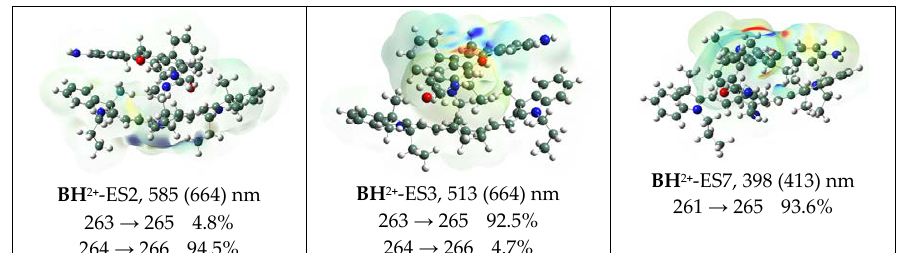
Figure 9. Current density difference illustrations as iso-surfaces of the probes as indicated for the excited states (ES) and the calculated and (experimental) wavelength. The composition of that specific ES together with percentage contribution is also indicated. Drawings of the numbered linear combination of atomic orbitals (LCAOs) are available in Supporting Information. Red areas indicate values for the different density of − 5.000 × 10 −5 and blue are for 5.000 × 10 −5 , see scale on top of illustration.